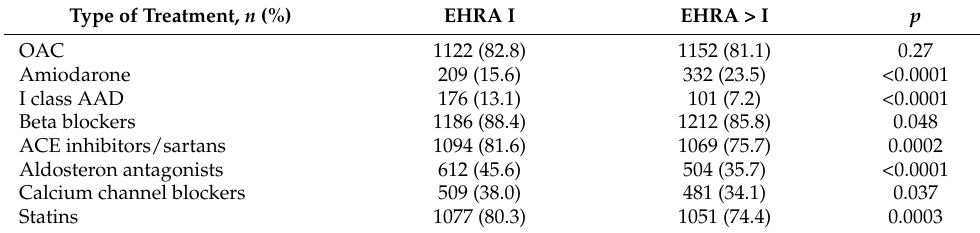
Table 4. Pharmacotherapy.